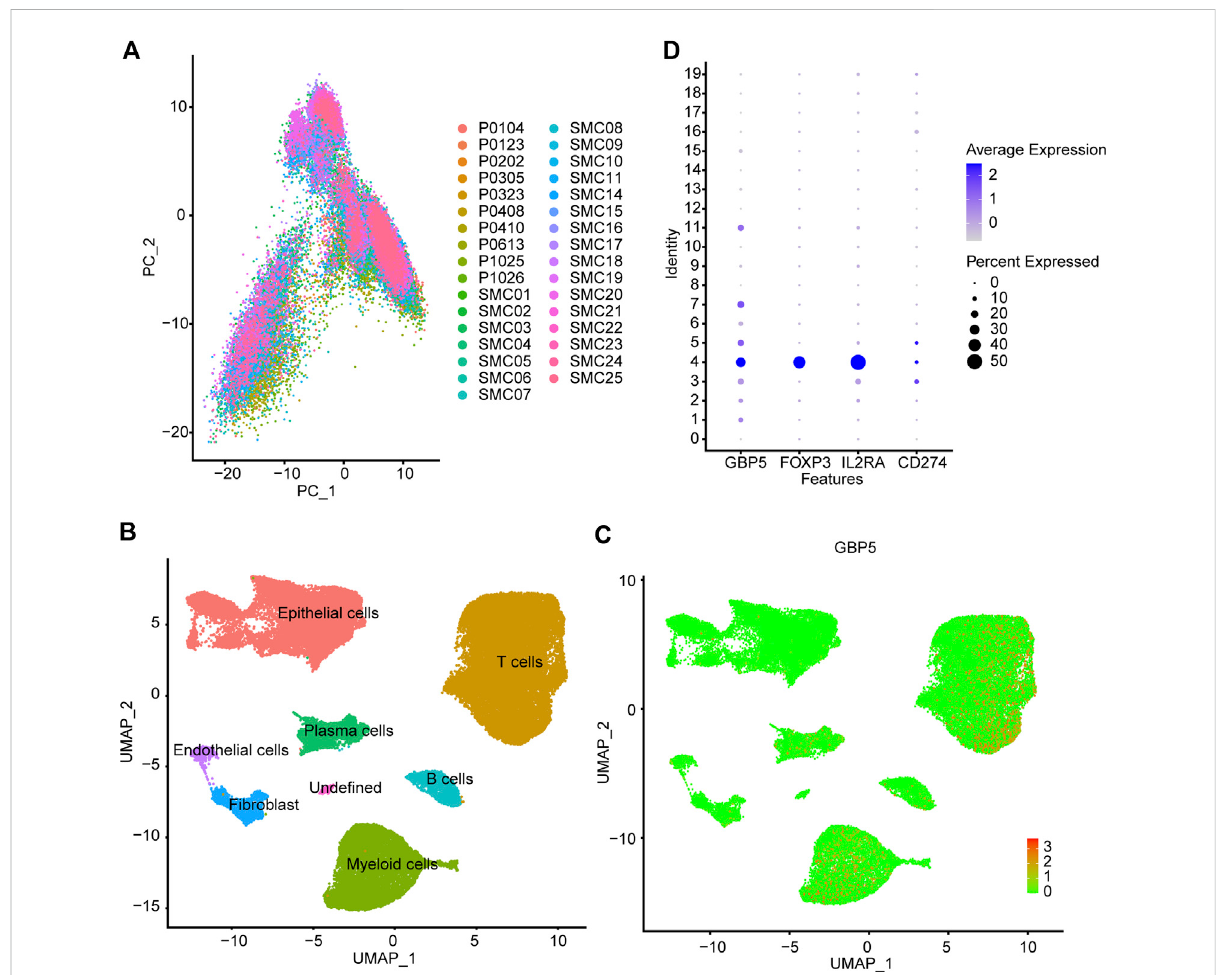
FIGURE 6 Single cell analysis of GBP5 expression in CRC (A) PCA (Principal component analysis) shows no signi fi cant separation of CRC samples (B) According to the composition of marker genes, the 20 cell clusters are annotated by singleR and CellMarker. (C) Expression of GBP5 at single cell level in CRC (D) The expression of GBP5, FOXP3, IL2RA and CD274 (PD-L1) in 20 cell